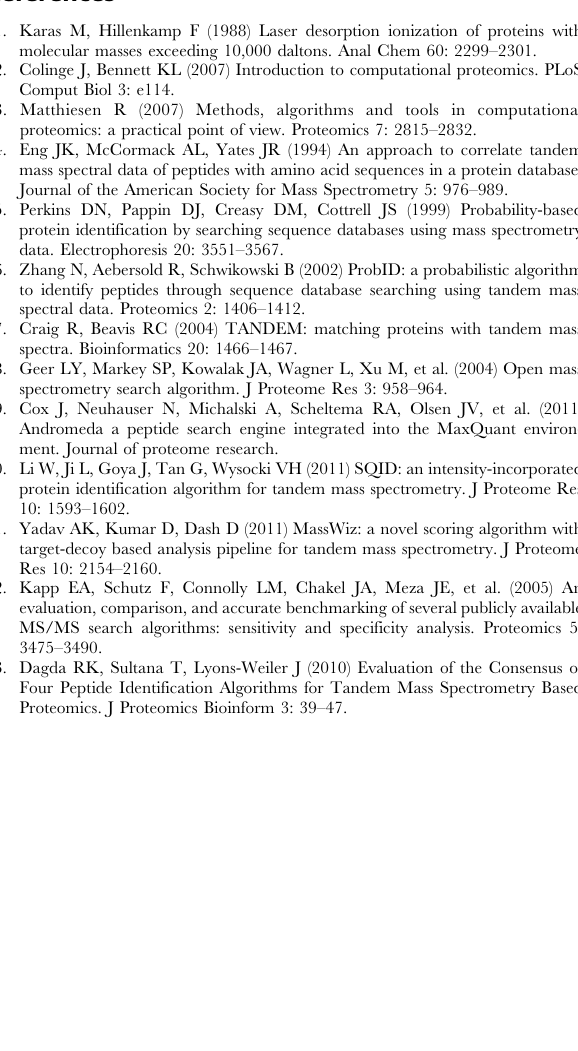
Table S2 The high-confidence peptides of the three